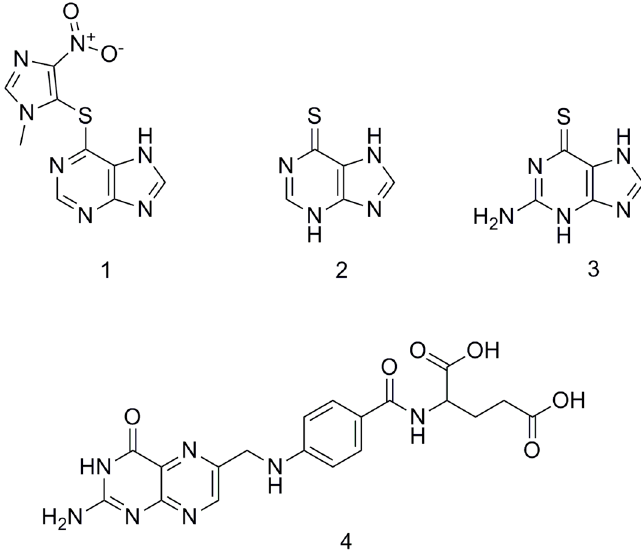
Figure 1. Chemical structures of azathioprine (1), 6-mercaptopurine (2), 6-thioguanine (3) and folic acid (4).